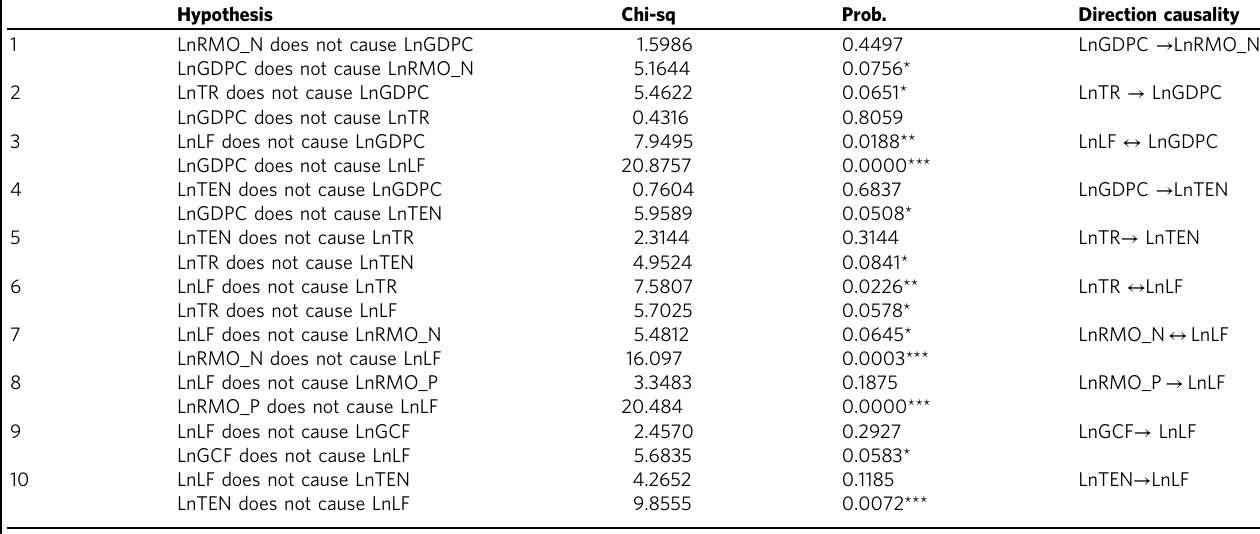
Table 9 VEC Granger causality test outcomes.